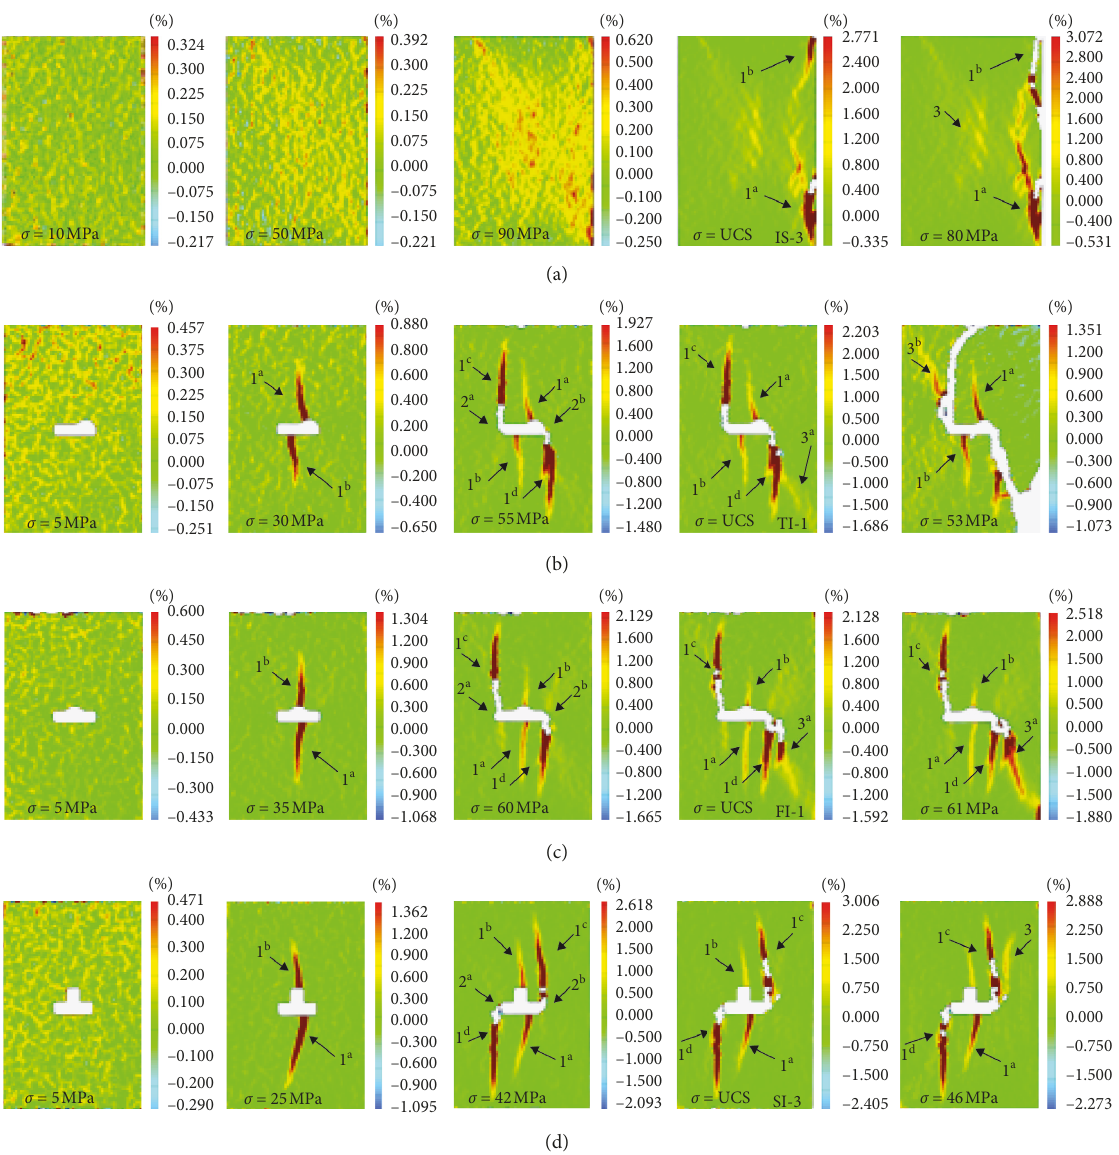
Figure 8: Fracture evolution of different specimens under axial loads: (a) specimen IS-3; (b) specimen TI-1; (c) specimen FI-1; (d) specimen